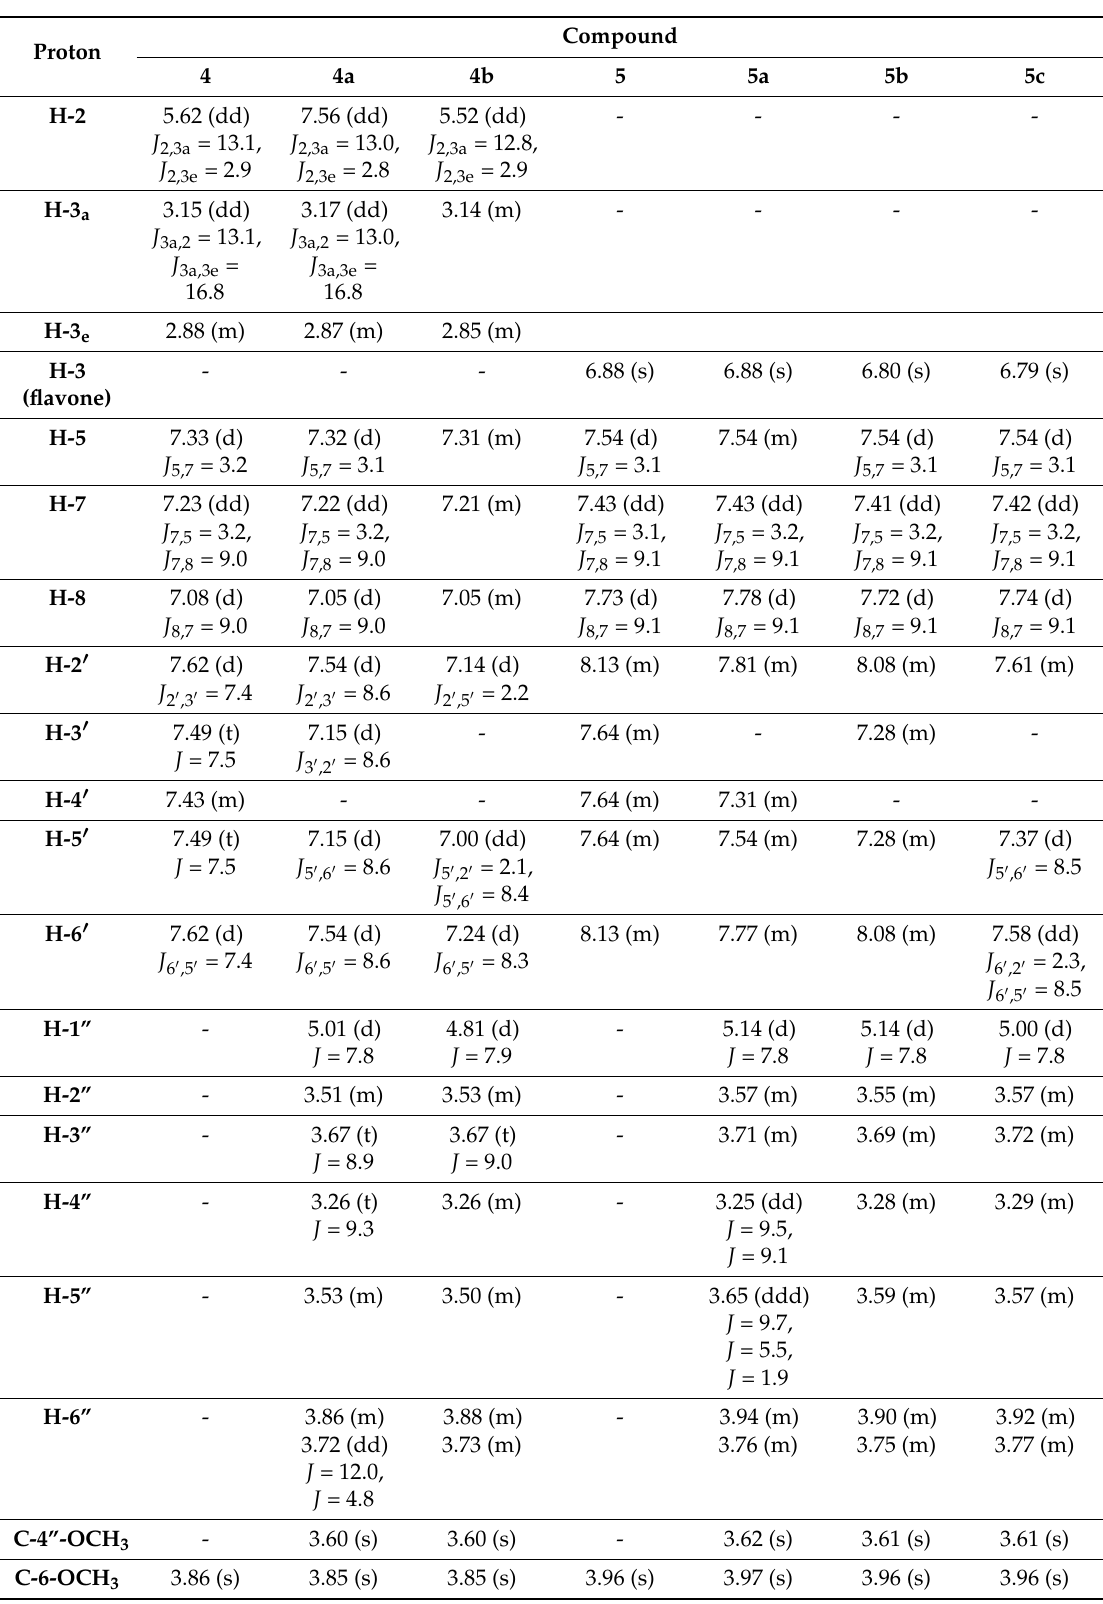
Table 5. The 1 H-NMR shifts ( δ ) (ppm) and coupling constants ( J H,H ) (Hz) of 6-methoxyflavanone ( 4 ) and 6-methoxyflavone ( 5 ) and the products of their biotransformations ( 4a , 4b , 5a , 5b , 5c ) in Acetone-d 6 , 600 MHz (Supplementary